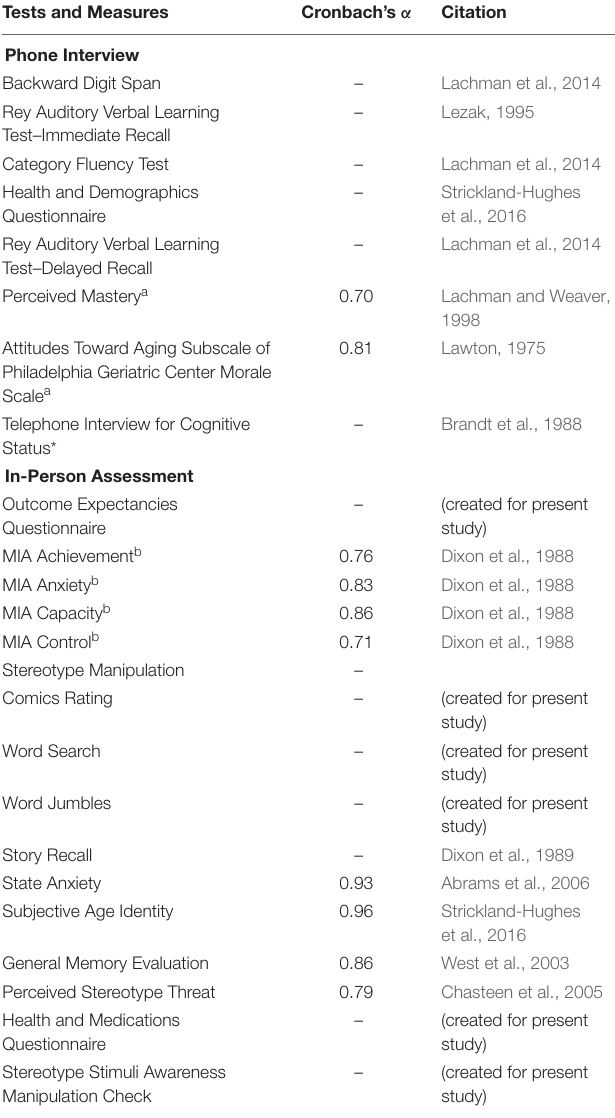
TABLE 2 | Presentation order of telephone interview and in-person assessment tests and